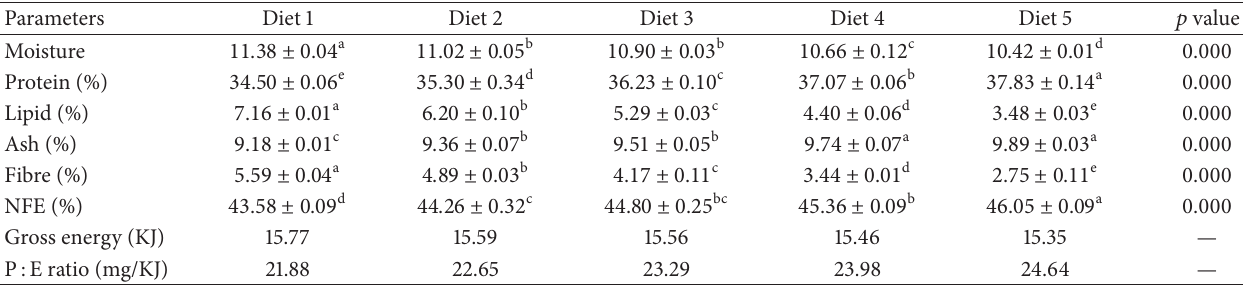
Table 4: Proximate composition of diets with dried brewer’s yeast meal (DBYM) in replacement of soybean meal (dry matter basis). Parameters